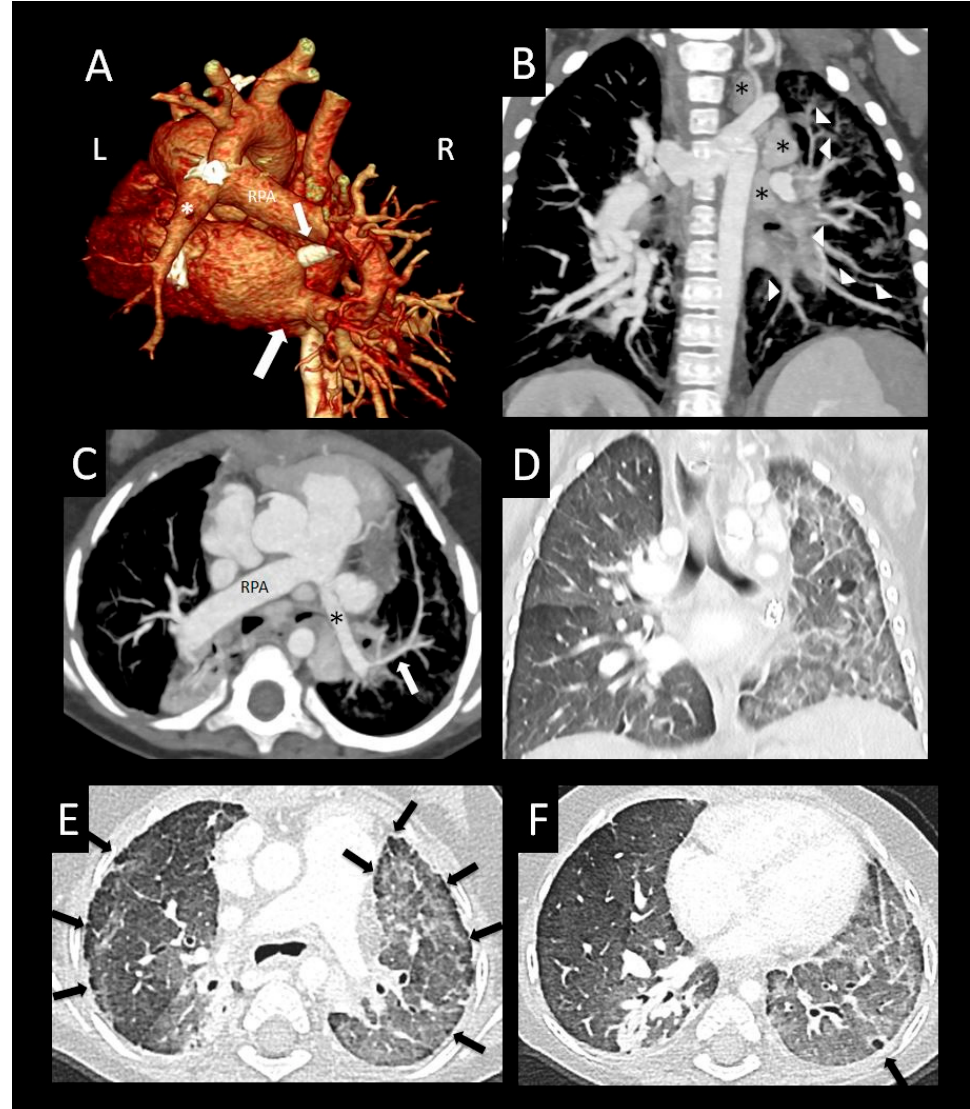
Figure 9. Peripheral cysts in a premature infant with pulmonary vein stenosis. Thirty-four-week premature infant status post atrial septal defect and muscular ventricular septal defect closure, omphalocele repair, and subsequent sutureless repair of the right upper pulmonary vein and left common confluence pulmonary vein. Postoperative CT posterior volume rendered image ( A ) shows no left pulmonary veins entering into the left side of the left atrium consistent with left common pulmonary vein atresia. Note the large right lower pulmonary vein (large arrow) and stented right upper pulmonary vein (small arrow). The peripheral left pulmonary artery (*) and branches are smaller than the right pulmonary artery (RPA). Coronal image ( B ) shows severely hypoplastic peripheral left upper pulmonary vein and left lower pulmonary vein (arrowheads) with diminished enhancement relative to the other vessels with surrounding left-sided perihilar induration. Axial image ( C ) shows large right pulmonary artery and small left pulmonary artery (*) with a hypoplastic branch to the left upper lobe (arrow). Coronal ( D ) and axial ( E , F ) images with lung windows show left lung hypoplasia with diffusely increased interlobular septal thickening and ground glass opacity relative to the right lung. The architectural distortion and bilateral peripheral cysts (arrows) involving both lungs are more consistent with chronic lung disease of prematurity than with sequelae of pulmonary vein